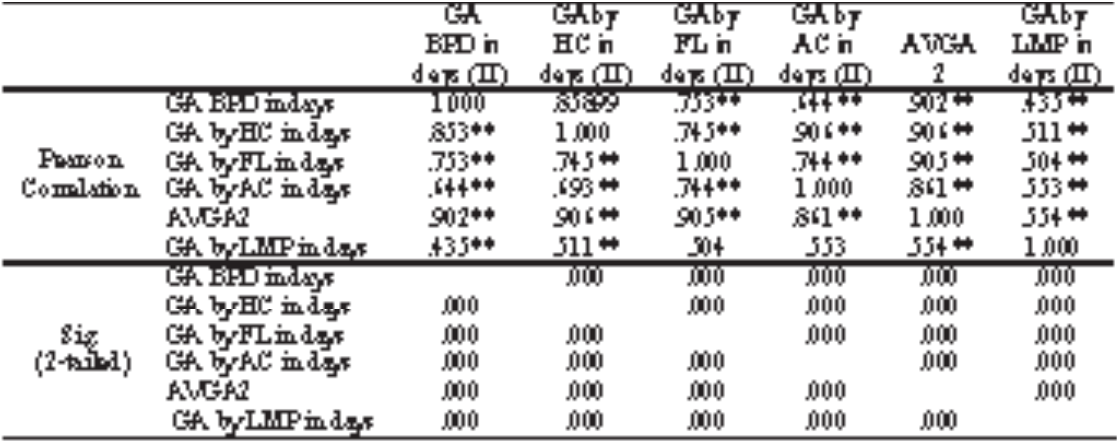
** Correlation is significant at the0.01 level (2-tailed).